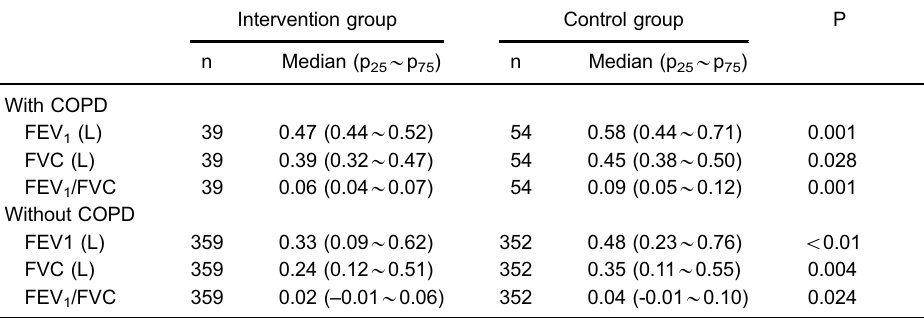
Table 4. Comparisons between the decline in lung function in the intervention and control groups after 18 years